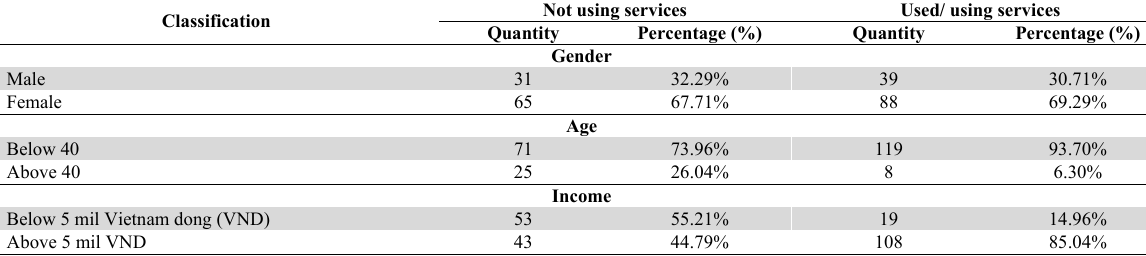
Description of demographic